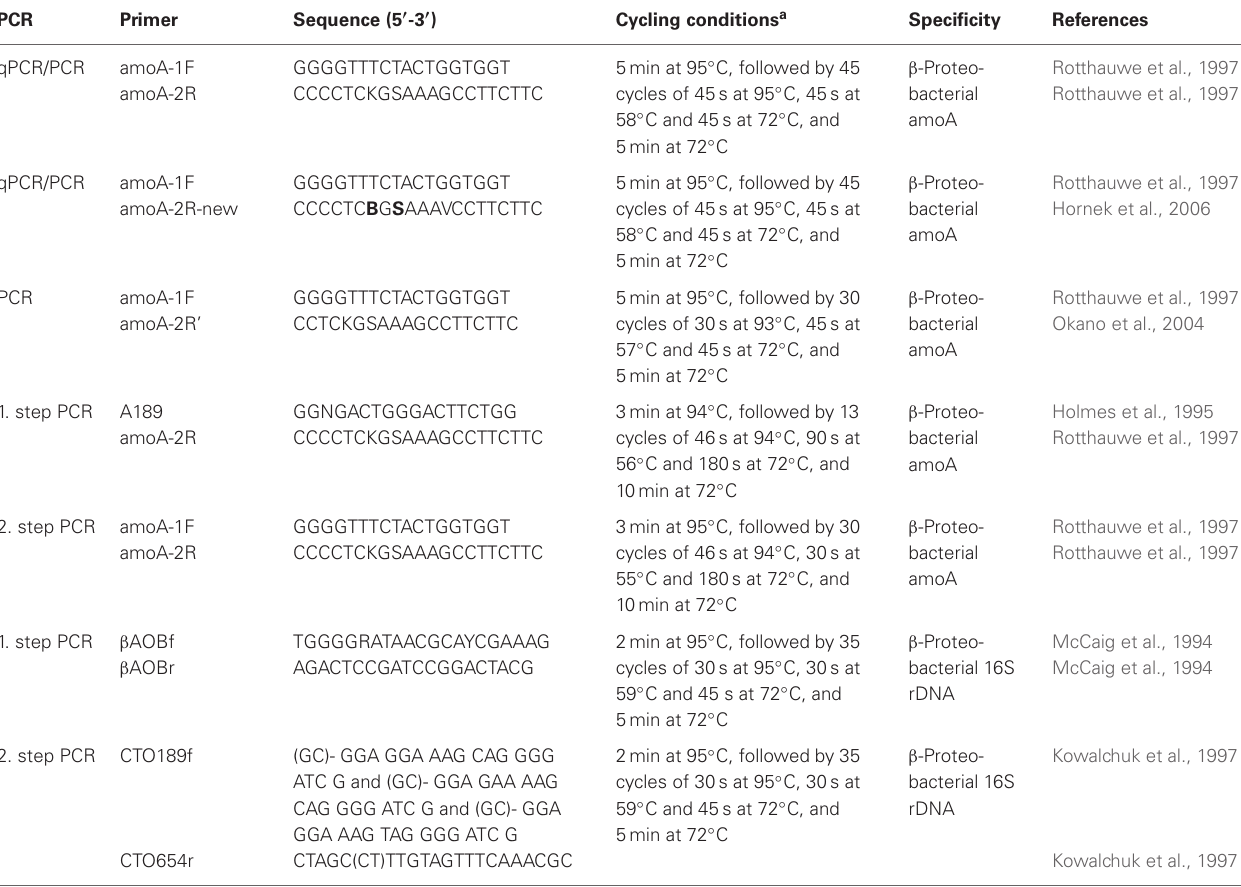
Table A2 | PCR primers and cycling conditions applied to amplify